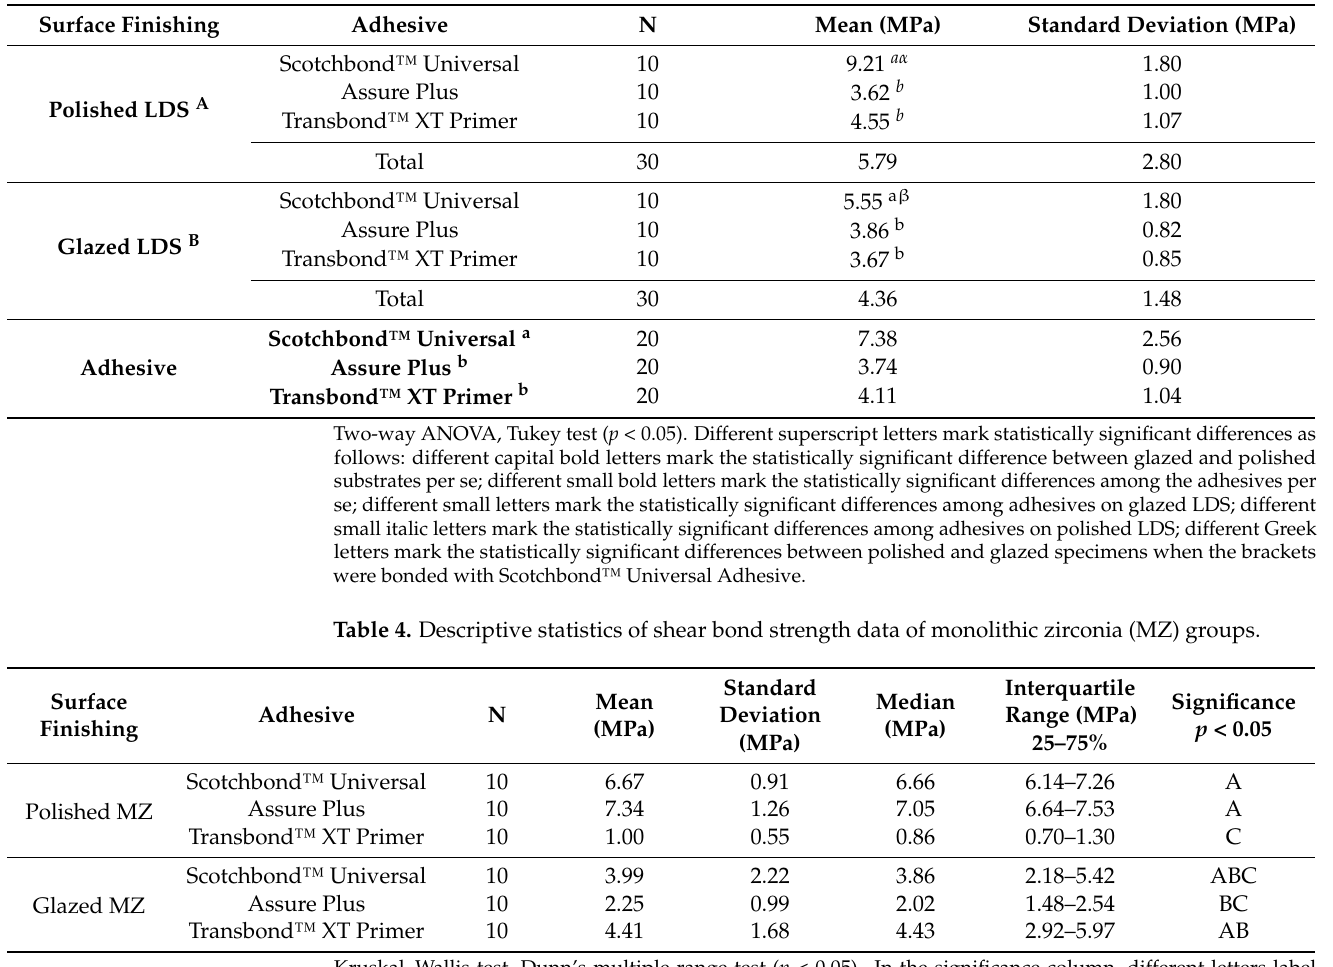
Table 3. Descriptive statistics of shear bond strength data of lithium disilicate glass ceramics (LDS) groups.